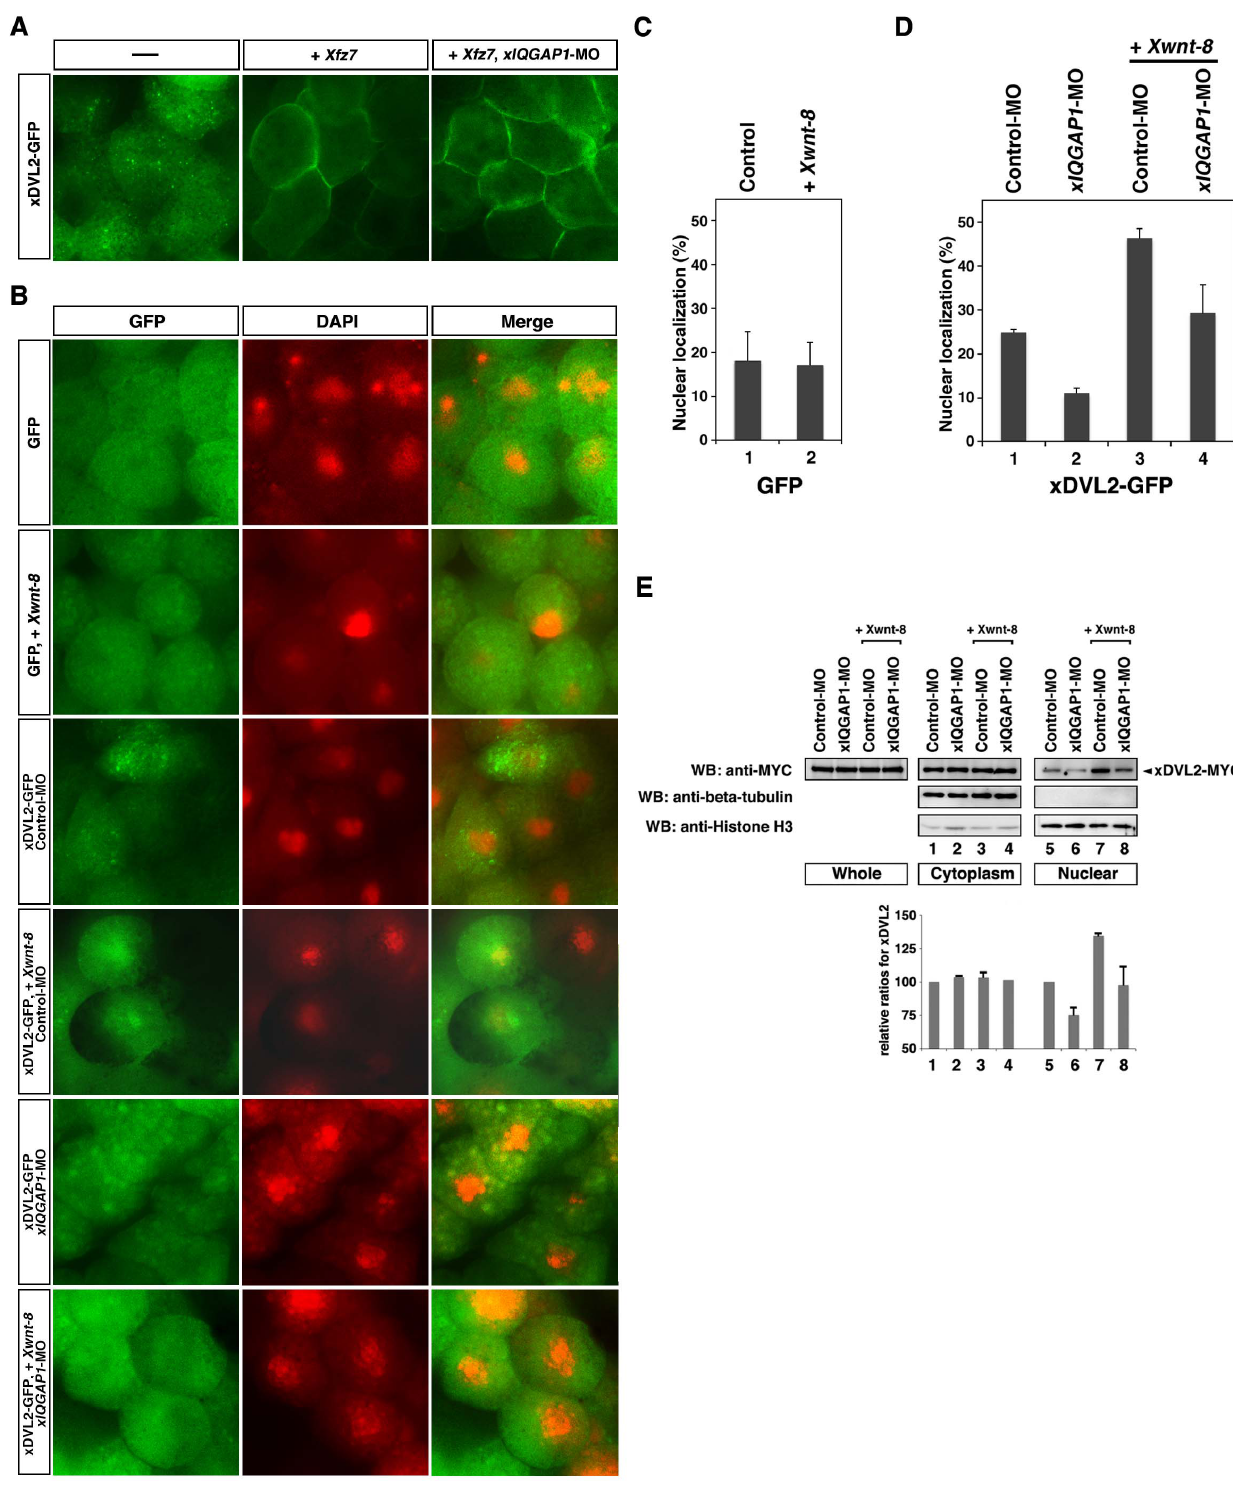
Figure 2. Localization of xDVL2-GFP. ( a,b ) Localization of xDVL2-GFP in Xenopus animal cap cells at stage 10. ( A ) xDvl2-GFP localized in punctate structures in the cytoplasm (left). Over-expression of Xfz7 recruited xDVL2-GFP to the plasma membrane (center). xIQGAP1 -MO did not affect the membrane localization of xDVL2-GFP induced by Xfz7 (right). ( B ) Nuclear localization of GFP and xDVL2-GFP caused by over-expression of Xwnt-8 and xIQGAP1 -MO. GFP signals (left). DAPI staining of animal cap cells (center). Merge (right). ( C, D ) The ratio of cells that had nuclear fluorescence signals. The average of ratio was taken with six explants in 3 independent experiments (See Materials and Methods). Error bars represent standard deviation of the mean with six explants. Statistical significance was determined by Student’s t -test. ( C ) The ratio of GFP localized in the nucleus in cells. Xwnt-8 was co-injected in lanes 2. Lane 1: n=291, 18.2%, lane 2: n=320, 17.2%. P . 0.1 [between lane 1 and lane 2]. ( D ) The ratio of xDVL2-GFP localized in the nucleus in cells injected with xIQGAP1 -MO. Xwnt-8 was co-injected in lanes 3 and 4. Lane 1: n=918, 26.0%, lane 2: n=1694, 11.0%, lane 3: n=263,